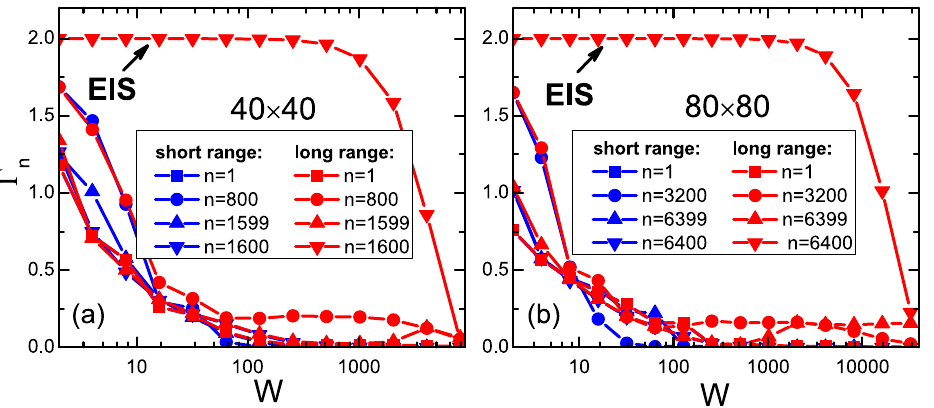
Figure 7. (Color online) The fractal dimension Ŵ n of the n -th eigenstate as a function of disorder strength W , for a certain sample with size 40 × 40 ( a ), and size 80 × 80 ( b ). Blue (red) color is for the short (long) range model. Notice horizontal scales in two panels are